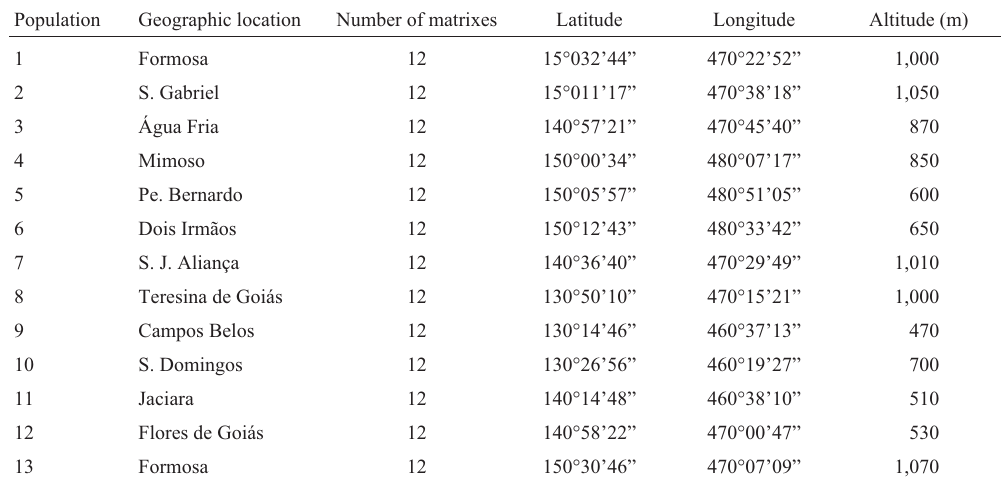
Table 1 - Number of populations and mother plants and respective geographic location of the Eugenia dysenterica DC collection areas in Goiás State. Population Geographic location Number of